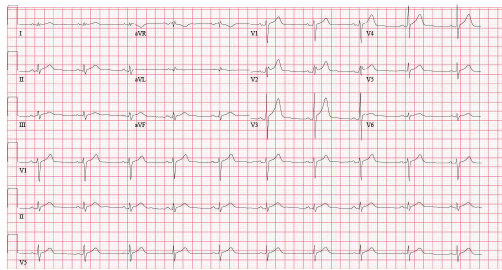
Figure 2: EKG showing marked improvement in ST elevation, low voltage QRS, and rightward axis.